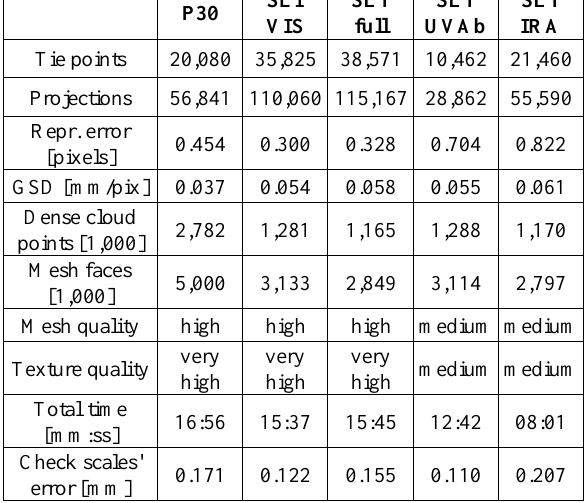
Table 6: Agisoft Metashape results OBJ1